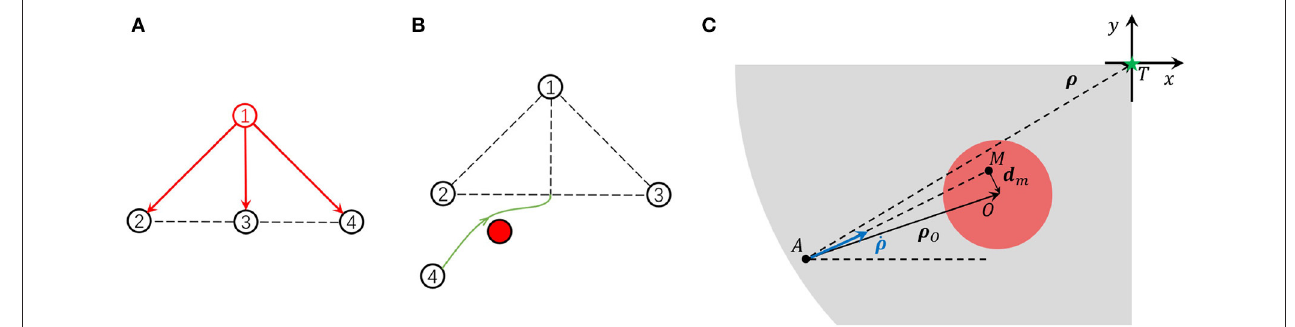
FIGURE 1 | (A) The leader-follower topology in the formation control. (B) The unit problem of formation control. (C) The relative kinematics